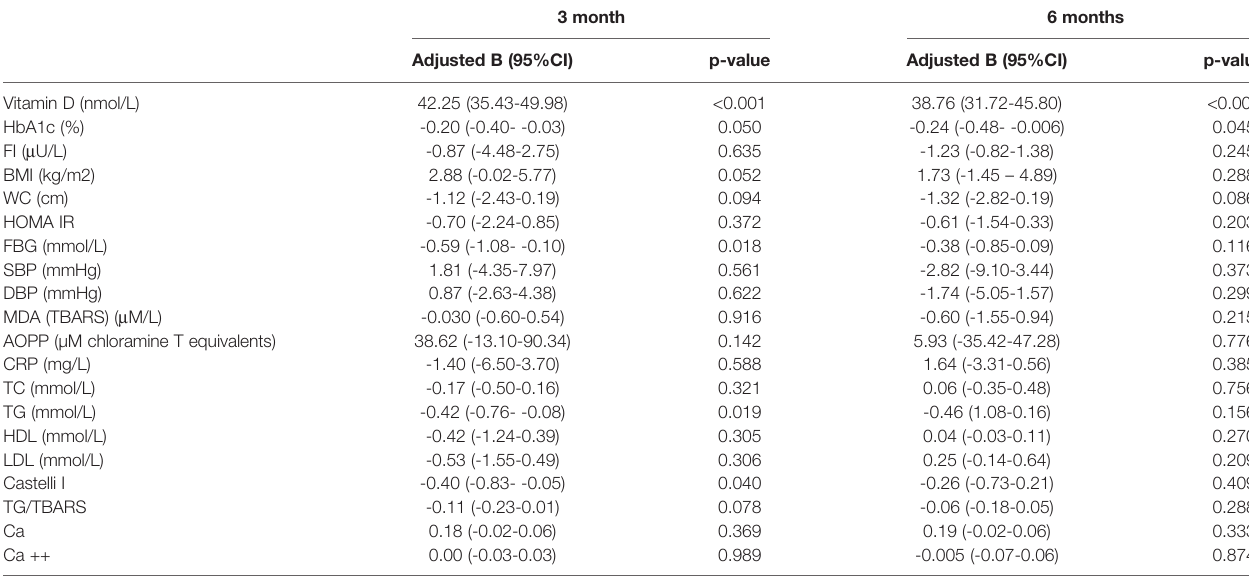
TABLE 4 | Adjusted p values of measured parameters over the 6-month period of vitamin D